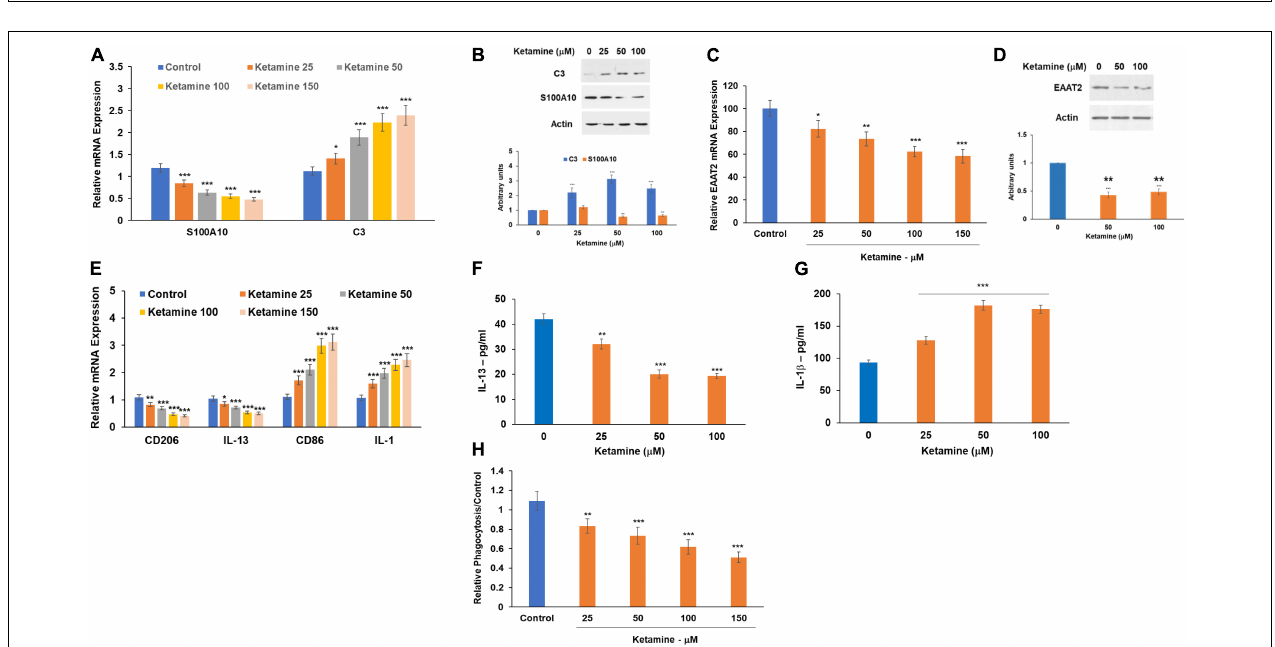
FIGURE 2 | Ketamine induces activation of astrocytes and microglia cells. Human astrocytes were treated with ketamine and were analyzed after 48 h for the expression of A1 (C3) and the A2 (S100A10) markers using RT-PCR (A) and Western blot analysis (B). The expression of the glutamate transporter EAAT2 mRNA was analyzed using RT-PCR (C) and Western blot analysis (D). Human microglia cells were treated with ketamine and the relative expression of M1 and M2 markers was analyzed using RT-PCR (E). The ketamine treated microglia cells were also analyzed for secretion of IL-1 β (F) and IL-13 (G) using ELISA and for phagocytosis using the pHrodoTM assay (H). The results are the means ± SD of a three independent experiments (A,C,E,H) or are a representative of three independent experiments (B,D,F,G) . * P < 0.05, ** P < 0.01, and *** P <